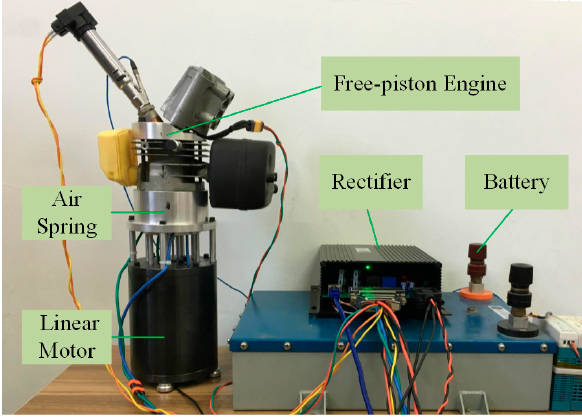
Figure 7. Prototype of the linear motor system and its test platform.